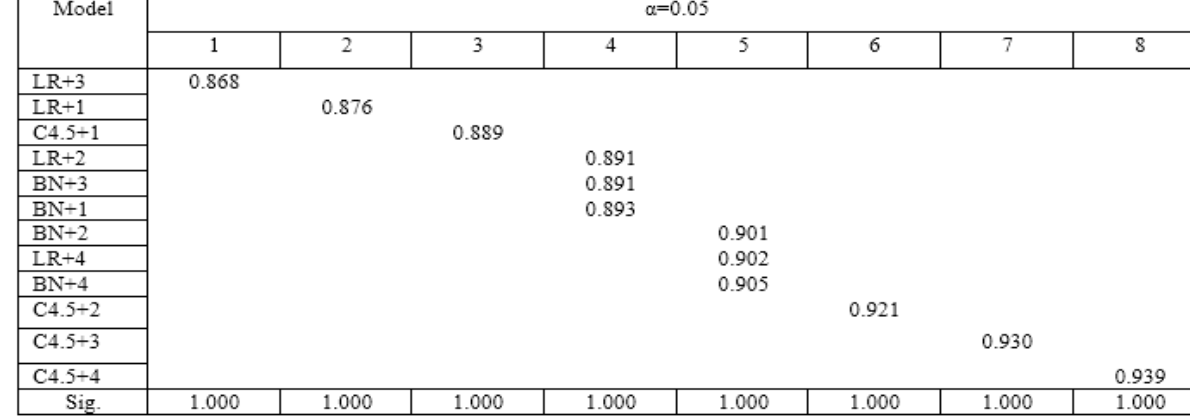
Figure 6. Tukey’s HSD test for